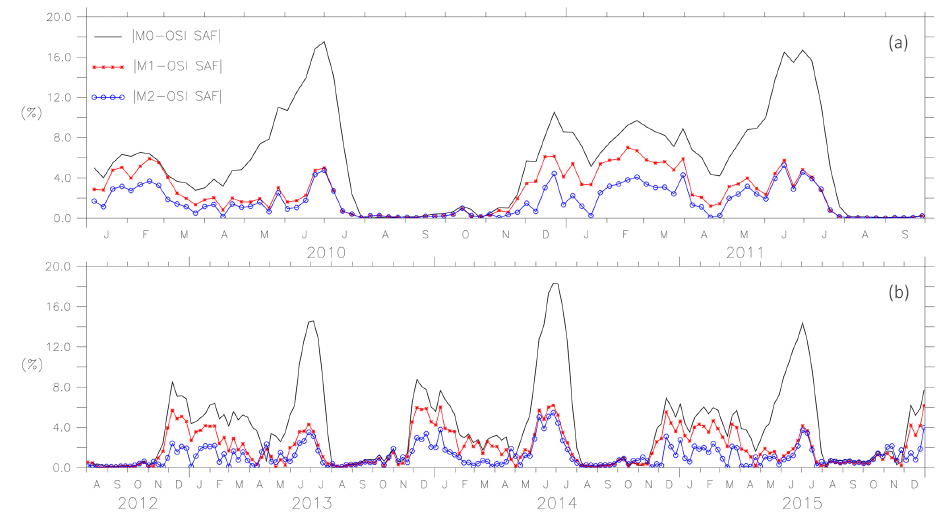
Figure 4. The absolute mean difference in ice concentration for models M0, M1 and M2 is shown for January 2010 to September 2011 in row 1 and for August 2012 to December 2015 in row 2.